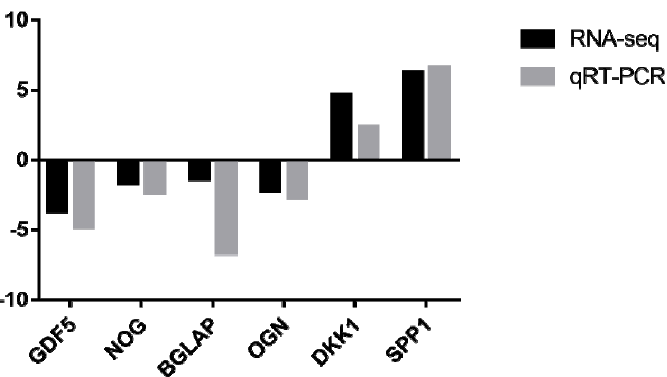
Figure 6. Comparison of mRNA expressions between real-time PCR and RNA-seq data. The gene expression values and Fragments Per Kilobase of exon model per Million mapped fragments (FPKM) values were transformed to log2 scale.